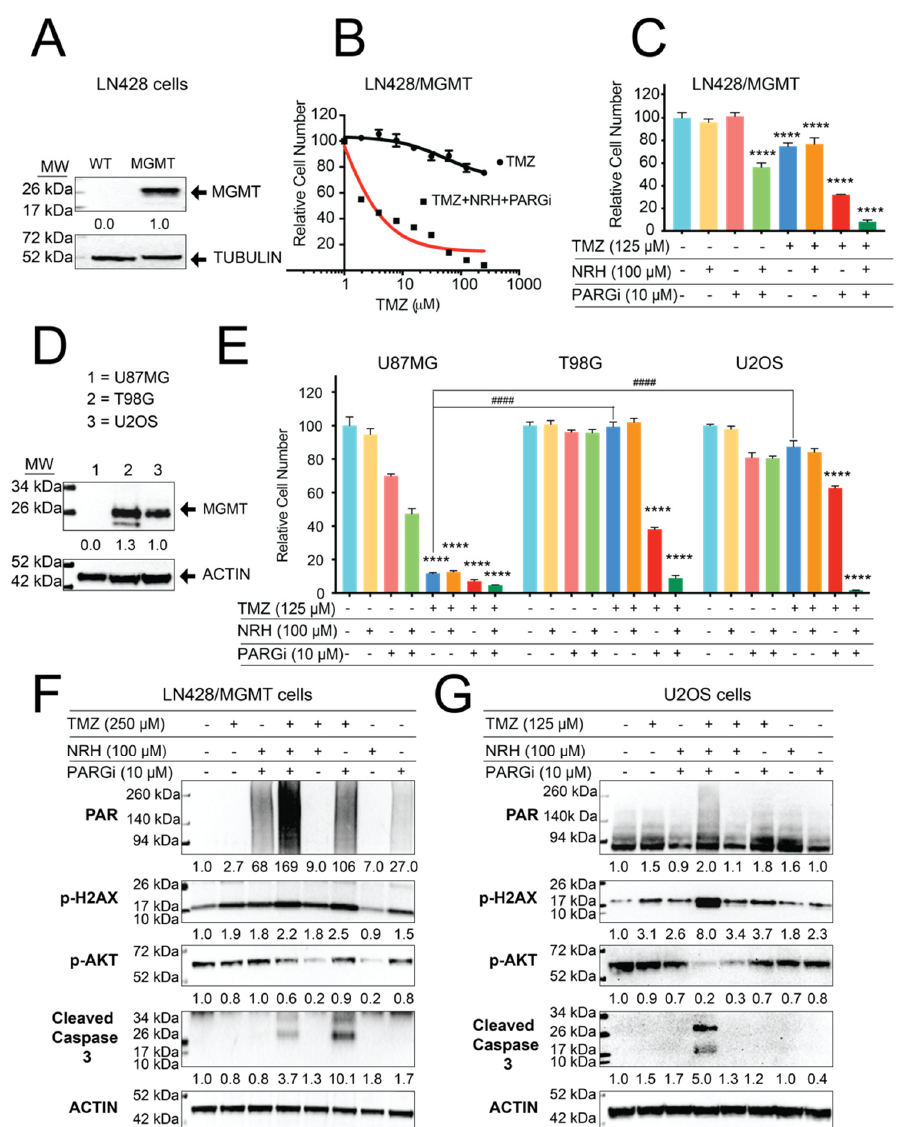
Figure 5. MGMT-mediated resistance to TMZ is overcome by a co-treatment with NRH and PARGi. ( A ) Immunoblot analysis of MGMT in LN428 cells (WT) modified to express human MGMT (LN428/MGMT). Tubulin was used as the loading control. ( B ) The relative number of LN428/MGMT cells after treatment with TMZ or NRH (100 μ M) + PARGi (10 μ M) plus TMZ for 7 days (TMZ doses as indicated), normalized to DMSO. ( C ) The relative number of LN428/MGMT cells after treatment with DMSO, NRH (100 μ M), PARGi (10 μ M), N + P, TMZ (125 μ M), T + N, T + P, or T + N + P for 7 days, normalized to DMSO (**** p < 0.0001, one-way ANOVA). ( D ) Immunoblot analysis of MGMT in U87MG, T98G, or U2OS cells. β -Actin was used as the loading control. ( E ) The relative number of U87MG, T98G, or U2OS cells after treatment with DMSO, NRH (100 μ M), PARGi (10 μ M), N + P, TMZ (125 μ M), T + N, T + P, or T + N + P for 7 days, normalized to DMSO (**** p < 0.0001 for each DMSO control; #### p < 0.0001 referred to TMZ treatment of U87MG cells, two-way ANOVA). ( F ) Immunoblot analysis of total cell lysates for PAR, p-AKT, γ -H2AX, and cleaved caspase 3, 24 h after treatment of LN428/MGMT cells with DMSO, NRH (100 μ M), PARGi (10 μ M), N + P, TMZ (250 μ M), T + N, T + P, or T + N + P. β -Actin was used as the loading control. ( G ) Immunoblot analysis of total cell lysates for PAR, p-AKT, γ -H2AX, and cleaved caspase 3, after 24 h treatment of U2OS cells with DMSO, NRH (100 μ M), PARGi (10 μ M), N + P, TMZ (125 μ M), T + N, T + P, or T + N + P. β -Actin was used as the loading control.